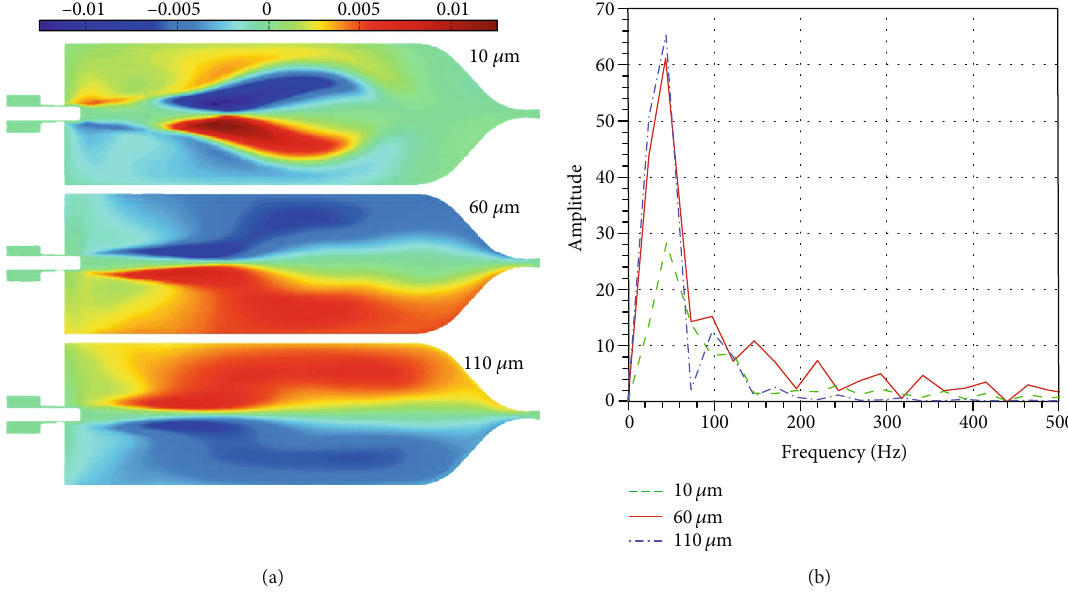
Figure 19: Space structures (a) of mode-1 and the spectrograms (b) of the corresponding time coe ffi cient for di ff erent initial LOX particle